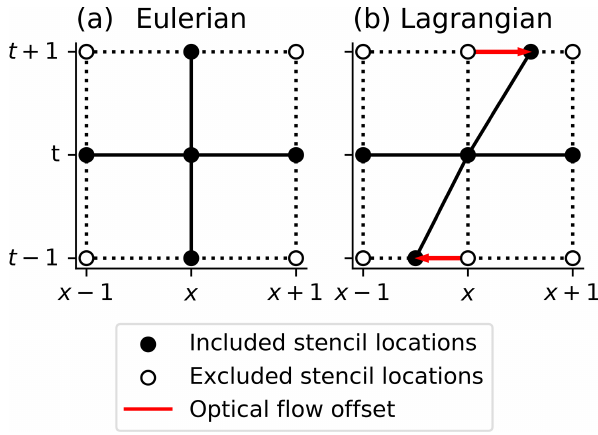
Figure 5. A comparison of convolution stencils with square con- nectivity in Eulerian (a) and Lagrangian (b) frameworks. In the La- grangian framework, the points at prior and subsequent time steps are offset by the calculated optical flow